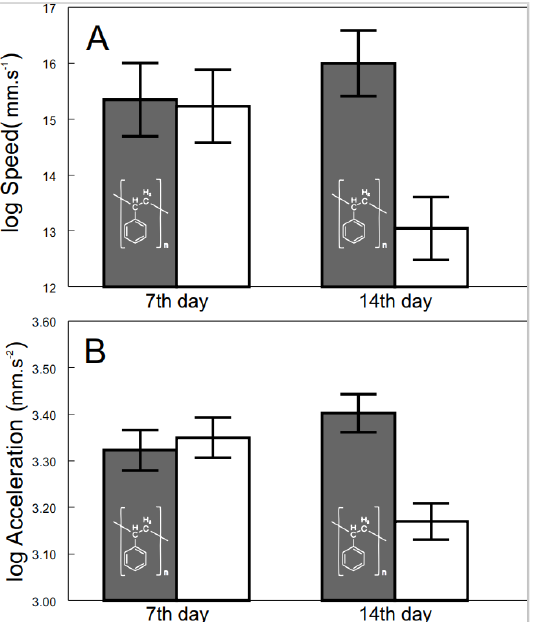
Figure 3. Speed ( A ) and acceleration ( B ) of exposed (grey bars with polystyrene formula) and control (white bars) shrimp across time. Values are adjusted means (+/ −